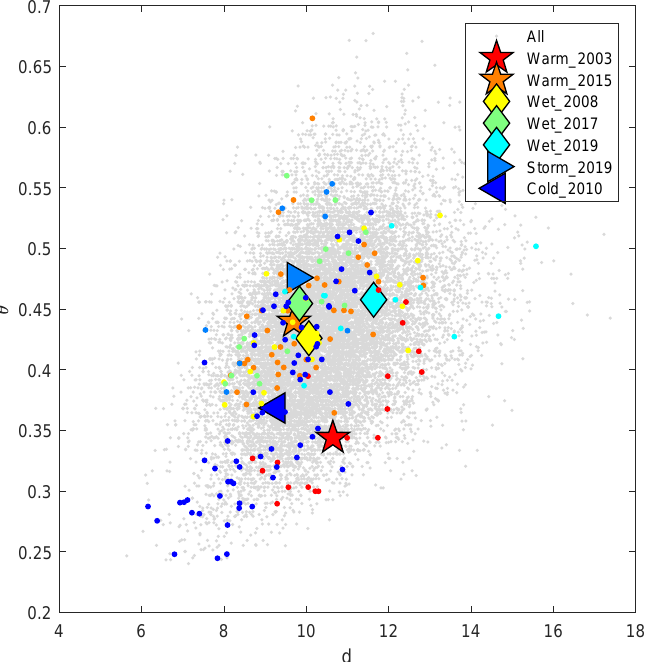
Figure 9. Scatter plot of the daily values of local dimension d and local persistence metric θ deter- mined from the Z500 of the ERA5 reanalysis data. The symbols indicate the median d and θ values for the seven events selected in Section 3, stars for heatwaves, diamonds for precipitation events, right triangle for the 2019 storm and left triangle for the 2010 cold spell. The coloured dots correspond to daily values of d - θ for each identified